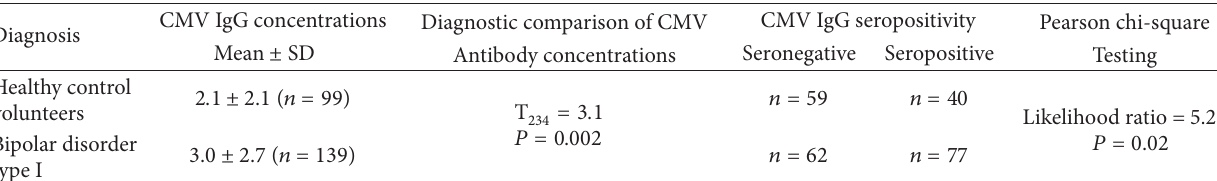
Table 3: Here we provide CMV IgG concentrations (reported as mean ± standard deviation in column 2) for each diagnosis, BD-I and healthy controls.